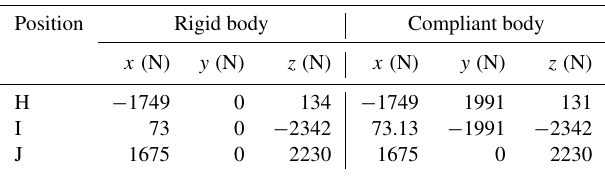
Table 7. Forces acting at hardpoints in rear suspension system in rigid-body and compliance models.